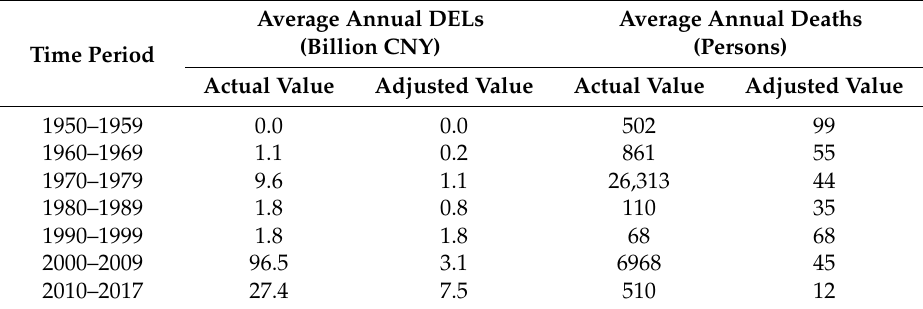
Table 4. Earthquake disaster impacts (DELs and deaths) by decade,